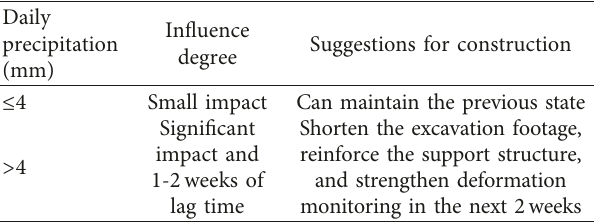
Table 2: Suggestion for construction of shallowly buried soft surrounding rock tunnel during atmospheric rainfall.